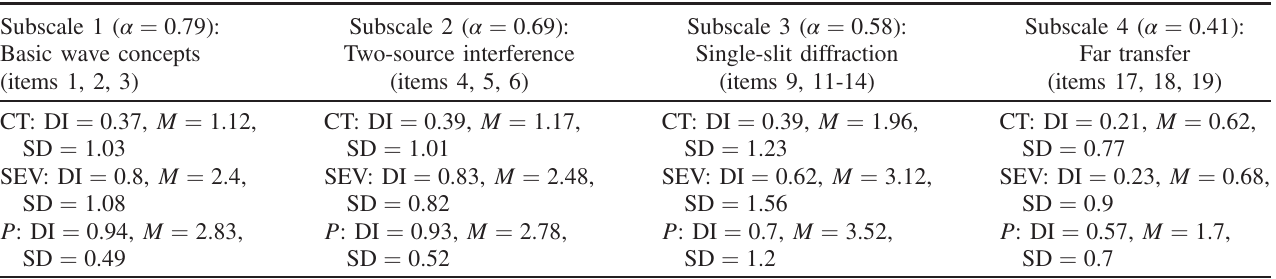
TABLE VI. Between-group comparisons across subscales. Note that only the items from the Rasch-compliant set were included. Difficulty index (DI), mean score ( M ), and standard deviation (SD) are provided. Subscale 1 ( α ¼ 0 . 79 ):